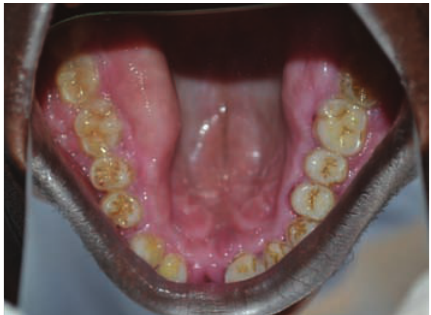
Figure 7: Clinical picture showing prominent enlargement in posterior region.